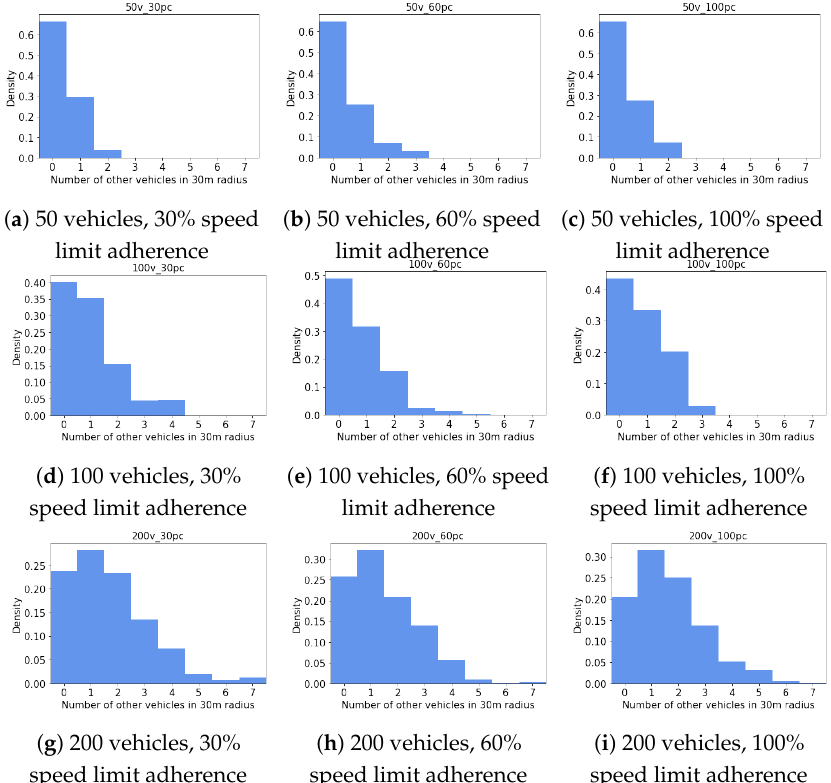
Figure 6. Distribution of number of additional vehicles involved in simulated collisions based on number of vehicles in system and proportion of vehicles adhering to speed